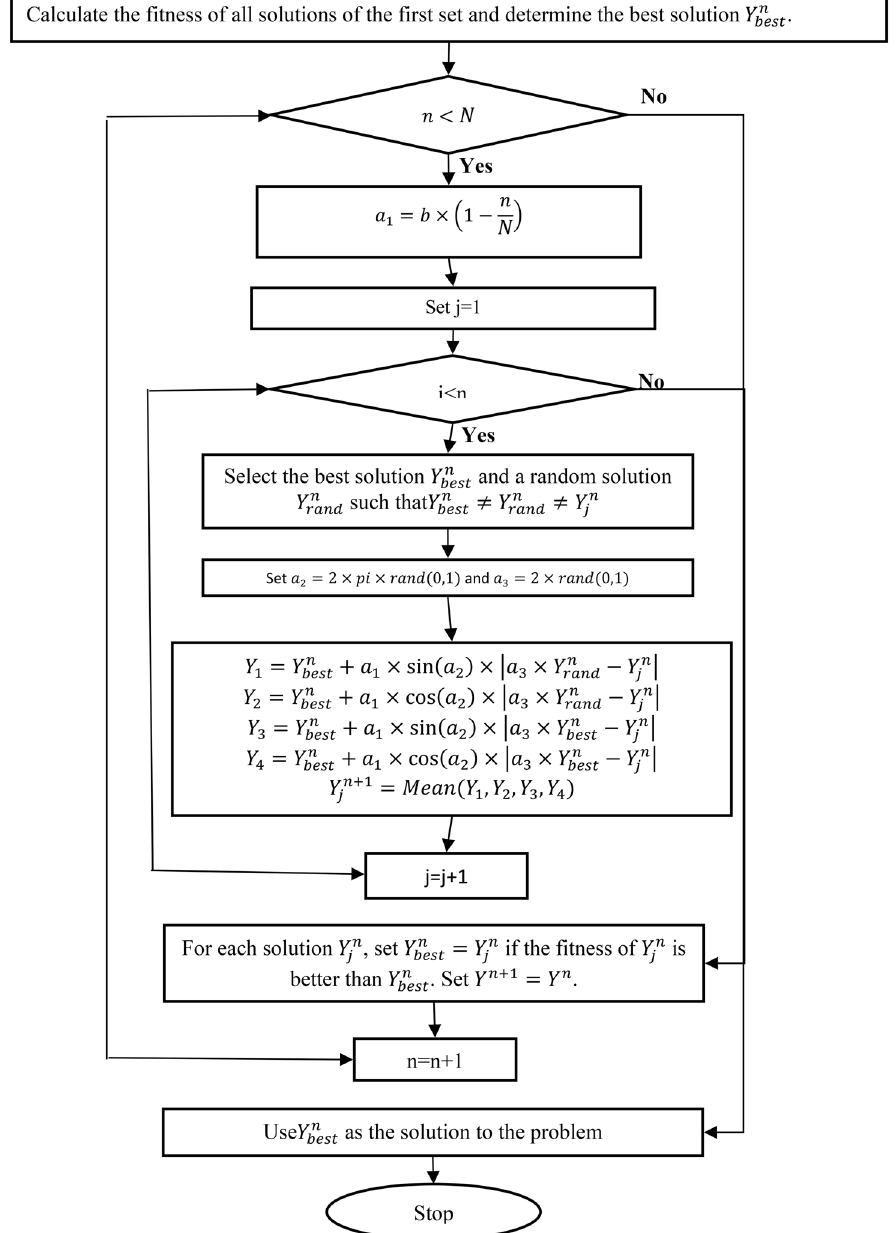
Fig. 3 Flow chart of